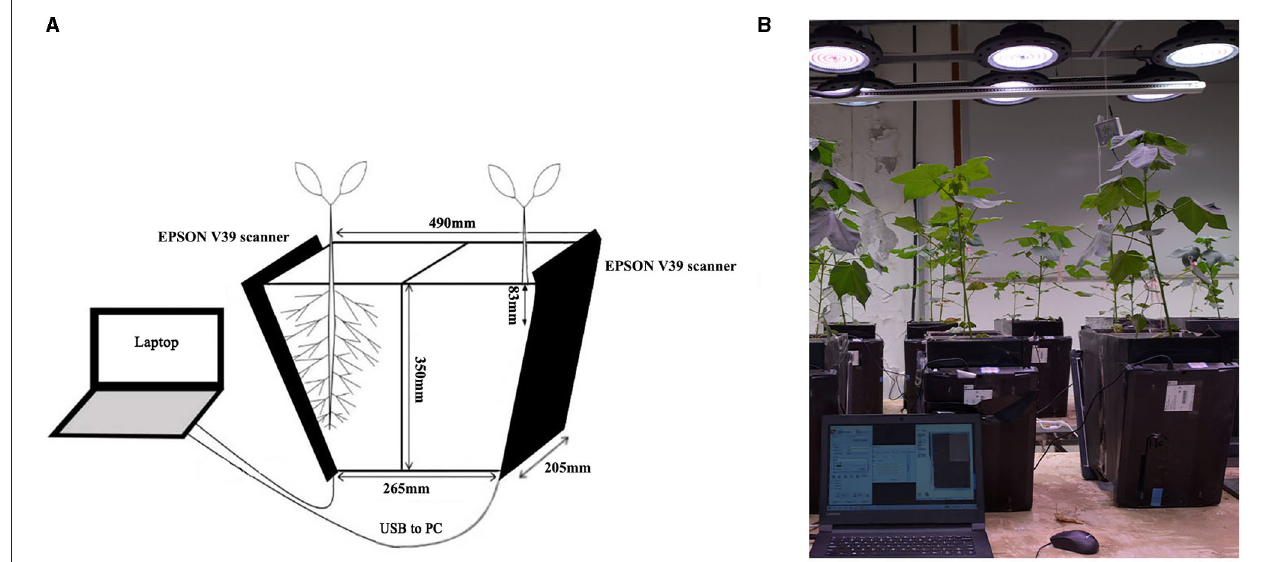
FIGURE 1 | Schematic representation (A) and image (B) of the RhizoPot growth-imaging device.